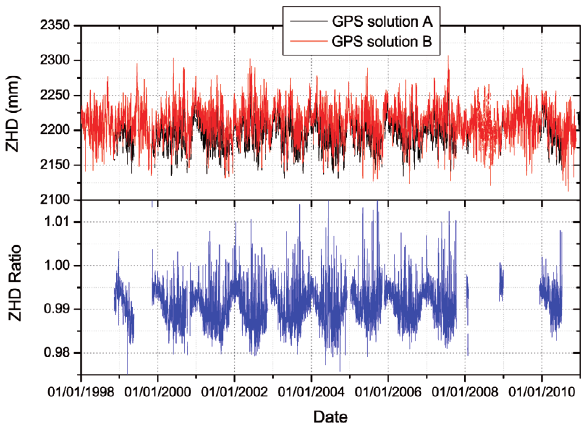
Figure 4. Top: Solution A (black), the ZHD time series for TNB1 ob- tained by interpolating the grid model values provided with the VMF1 mapping function coefficients (http://ggosatm.hg.tuwien.ac. at/DELAY/). Solution B (red), the ZHD time series obtained with Equation (6) and the surface pressure p data recorded at MZS by the automatic weather station Eneide. Bottom: Ratio of the ZHD times series (Solution A/Solution B; blue) shown in the top plot. The bias between the two series is represented by the discrepancy from unity. The seasonal variations of the bias are also